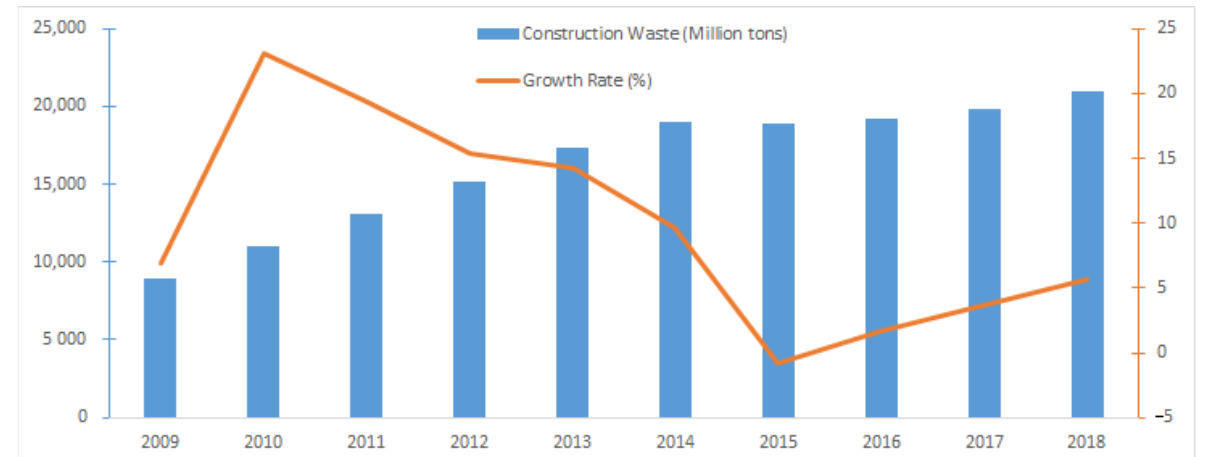
Figure 1. Study area.